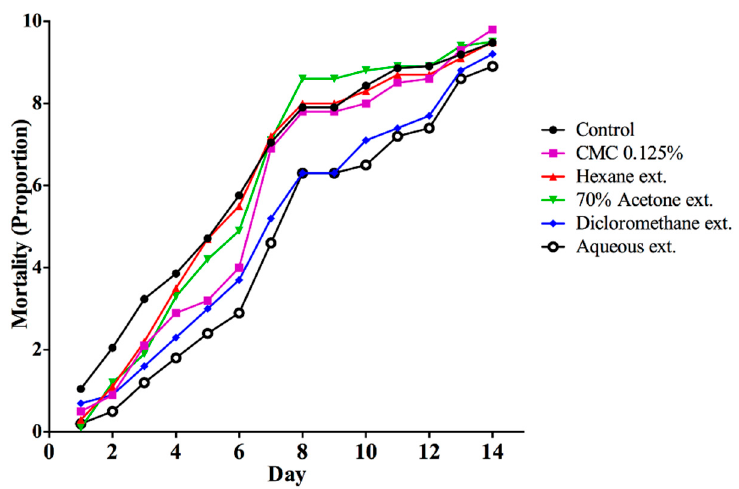
Figure 2. Effectiveness of Tithonia diversifolia extracts via contact to induce Atta cephalotes mortality over time. over